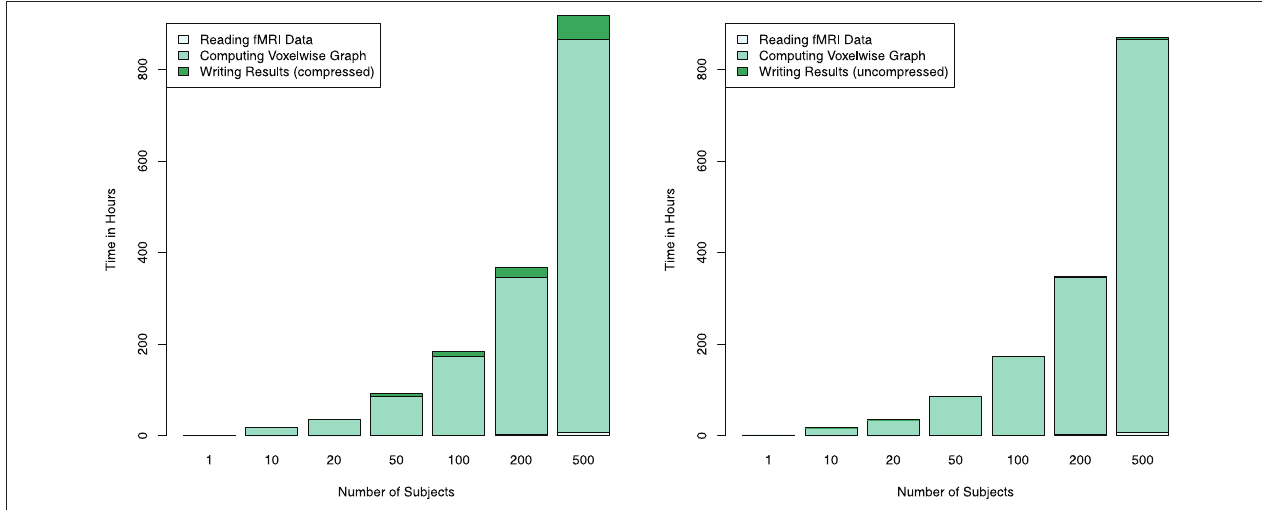
FIGURE 4 | Estimated combined computation times for reading the fMRI data, computing the connectivity graph and writing the thresholded (and thus sparse) connectivity matrix to compressed (left) and uncompressed (right) RData files are depicted for different numbers of subjects on a single GPU. Since computation time depends linearly on the number of subjects, computation time for larger numbers of subjects are estimated using average per-subject computing times measured from 200 subjects. By employing multiple GPUs the runtime can be reduced linearly; for example, using four GPUs instead of one for computing 500 subject’s connectivity graph would reduce the computation time from about 36 days down to 9.